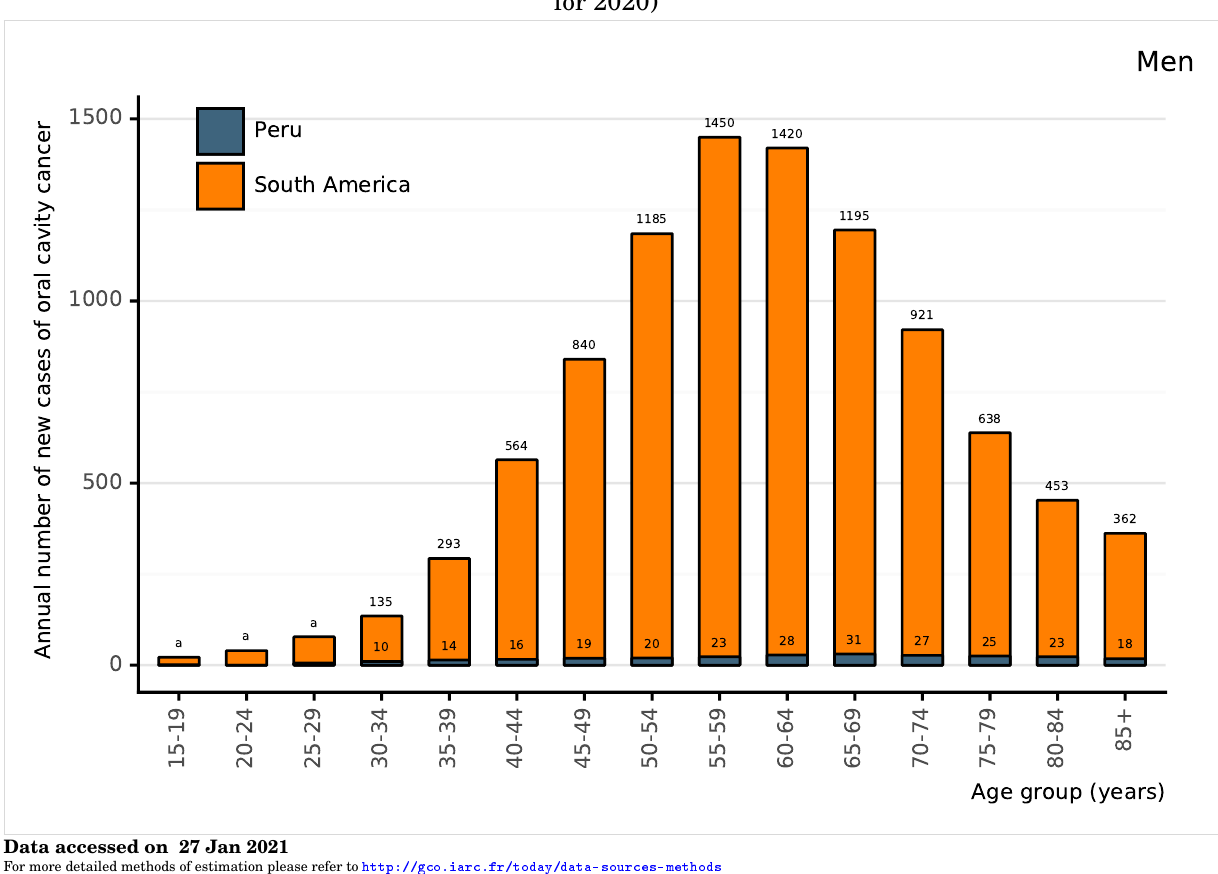
Figure 96: Annual number of new cases of oral cavity cancer among men by age group in Peru